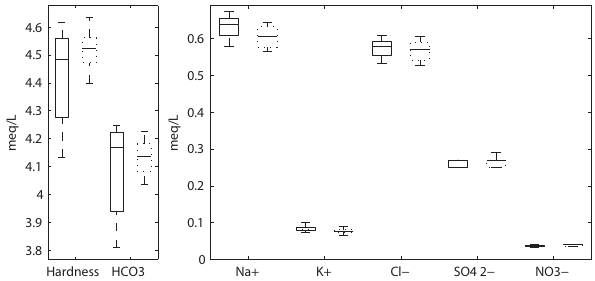
Fig. 6. Box plots comparing daily variation in hydrochemistry in river (solid) and near-river groundwater (dotted) in a monitoring- well R042 in the forest transect (transect B in Fig. 2) sampled every two hours over a period of two successive summer days. The line in the middle of each box is the sample median. If the median is not centered in the box, it shows sample skewness. The tops and bottoms of each “box” are the 25th and 75th percentiles of the sam- ples, respectively. The distances between the tops and bottoms are the inter-quartile ranges. Whiskers are drawn from the ends of the inter-quartile ranges to the furthest observations within the whisker length (the adjacent